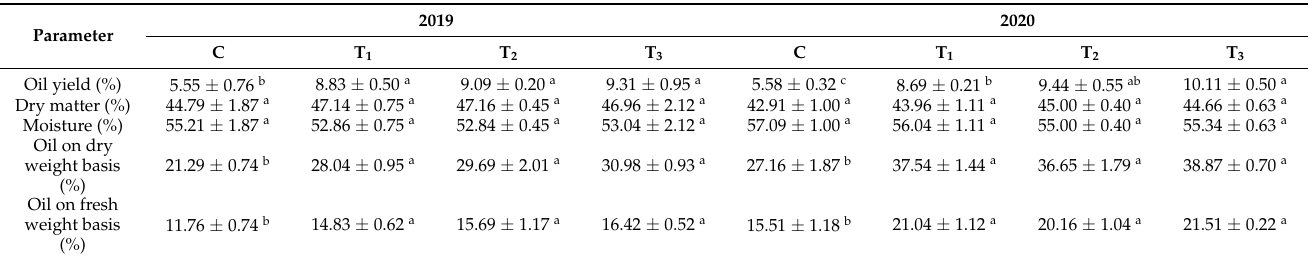
Table 3. Content of moisture, dry matter, oil on dry and fresh weight basis in olive paste, and oil yield during the production of virgin olive oils from Coratina cv. olive trees grown under different watering regimes during two crop seasons (2019 and 2020).